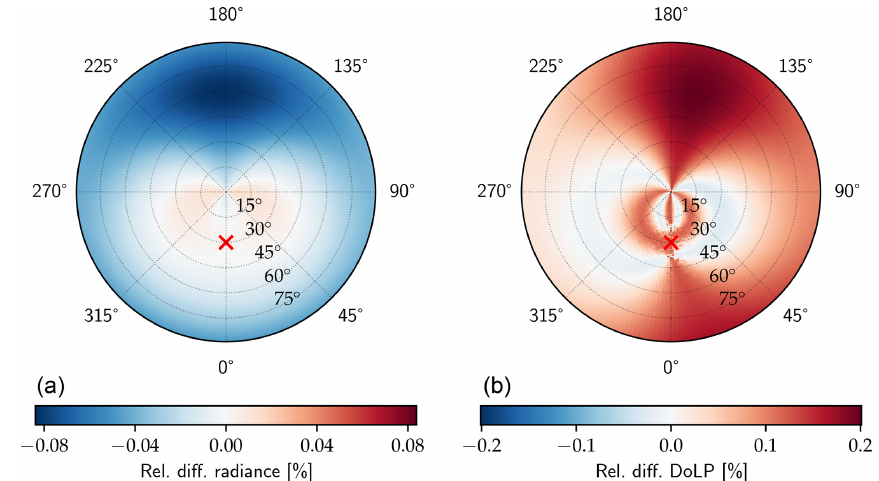
Figure 8. Same as Fig. 7 but for the remaining uncertainties in the diattenuation of the polarizers after performing the